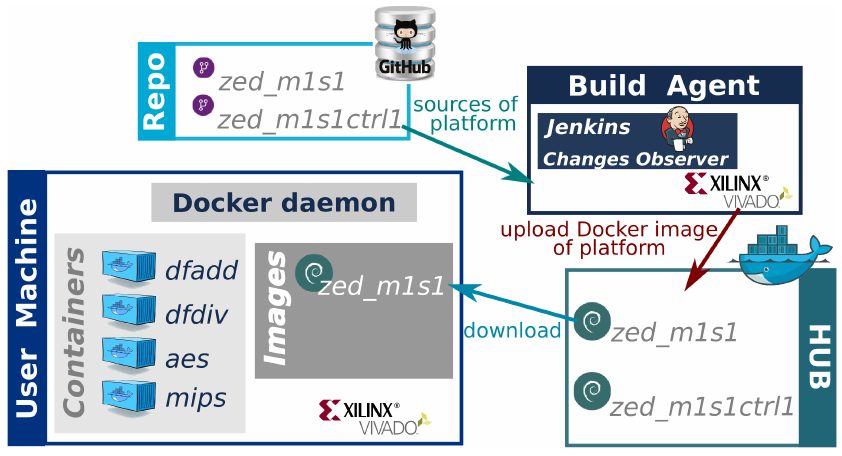
Figure 8. Building Docker images and